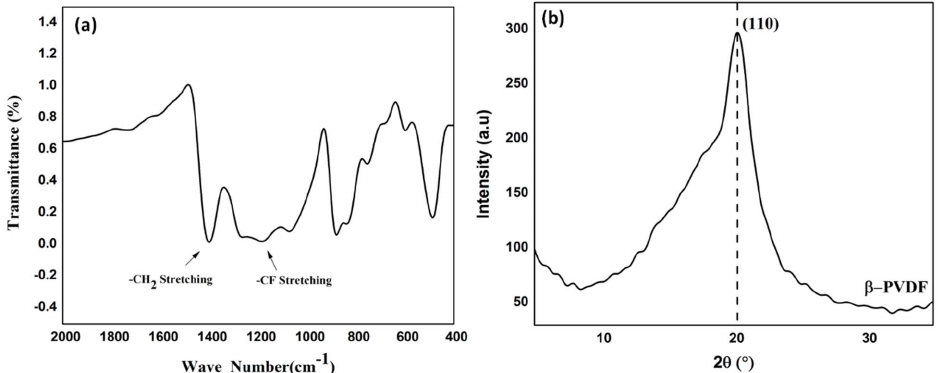
Figure 3. ( a ) FTIR and ( b ) XRD analyses of PVDF nanofibers.